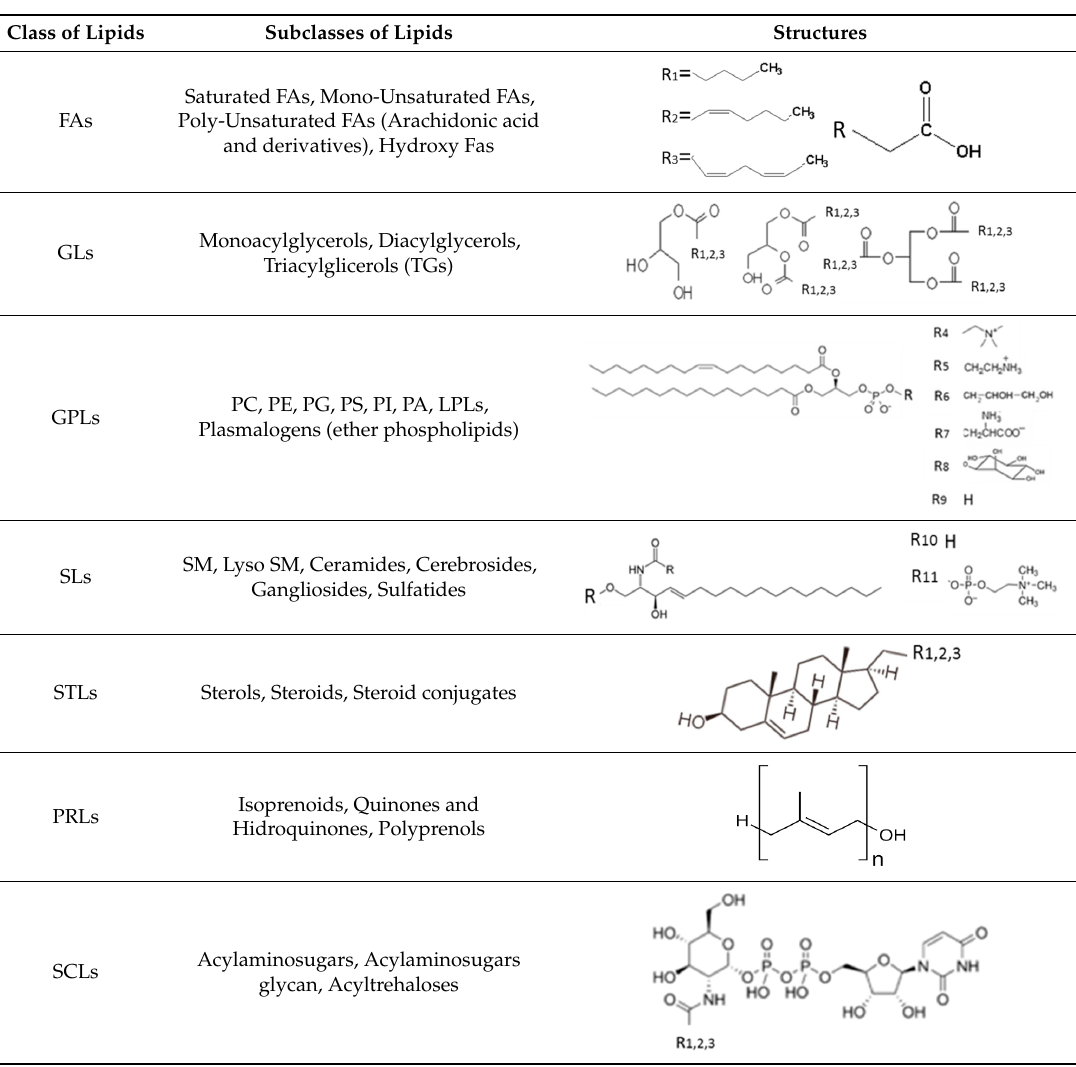
Table 1. Classification of lipids based on structures. The table lists different lipid classes and the main subclasses cited in the text. FAs: Fatty acids; GLs: Glycerolipids; GPLs: Glycerophospholipids; SLs: Sphingolipids; STs: Sterol lipids; PRLs: Prenol lipids; SCLs: Saccharolipids; R1: Aliphatic chain; R2: Mono-unsaturated chain; R3: Poly-unsaturated chain; R4: Polar head of PCs; R5: Polar head of PEs; R6: Polar head of PGs; R7: Polar head of PSs; R8: Polar head of PIs; R9: Structure of Pas; R10: Structure of Ceramide; R11: Polar head of SMs.